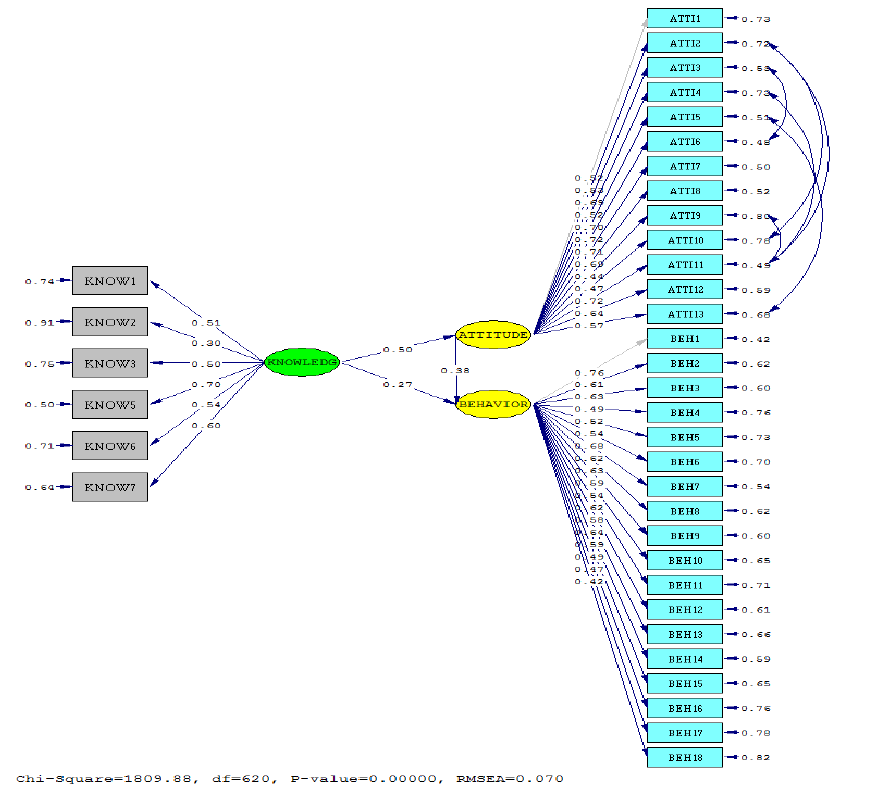
Fig.2: Structural Model Among Attitude, Behavior and Knowledge